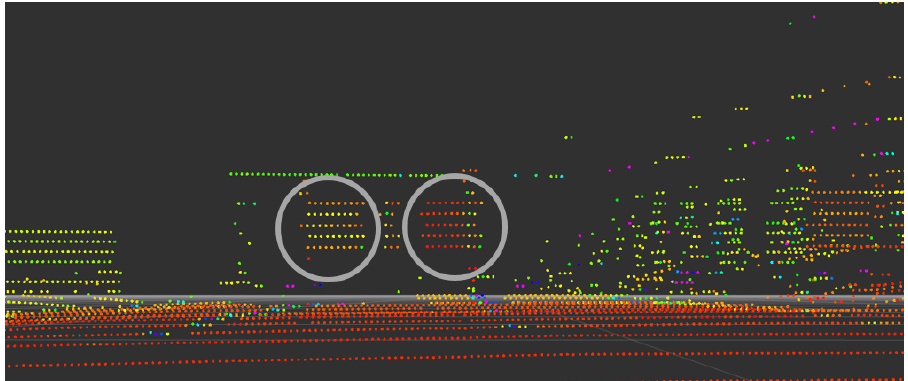
Figure 6. Object target displayed in point clouds (within gray circles).